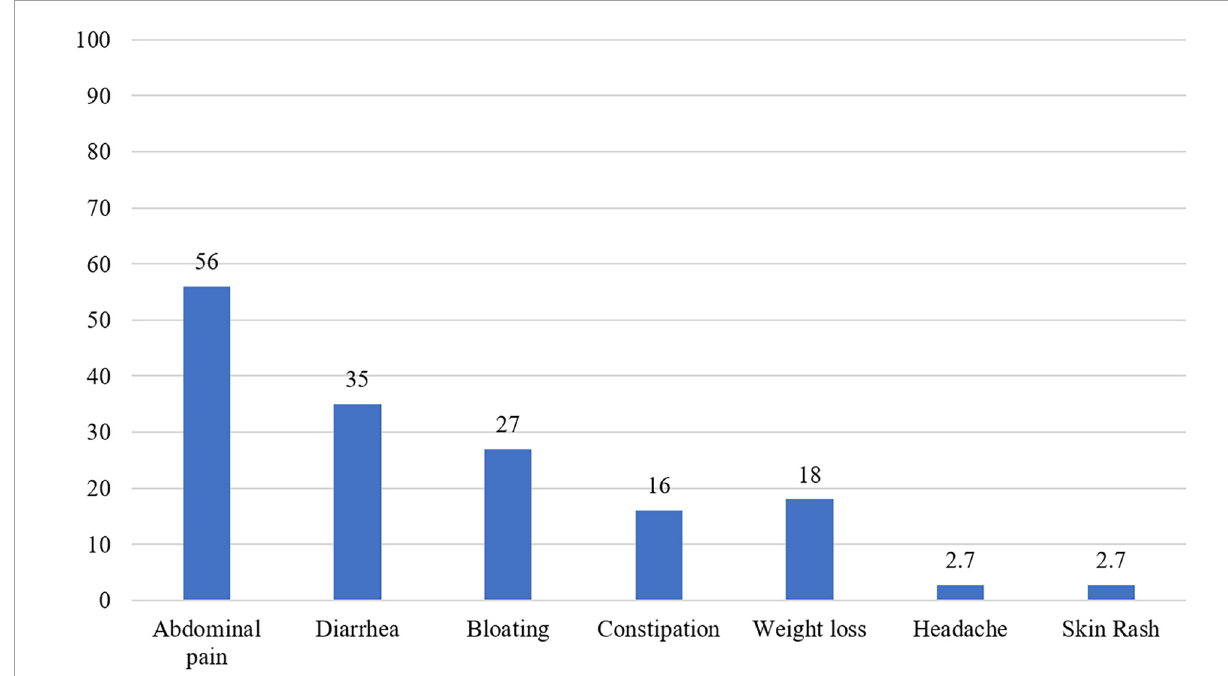
FIGURE2 A histogram showing the distribution of symptoms among the seropositive celiac disease patients ( n = 160).